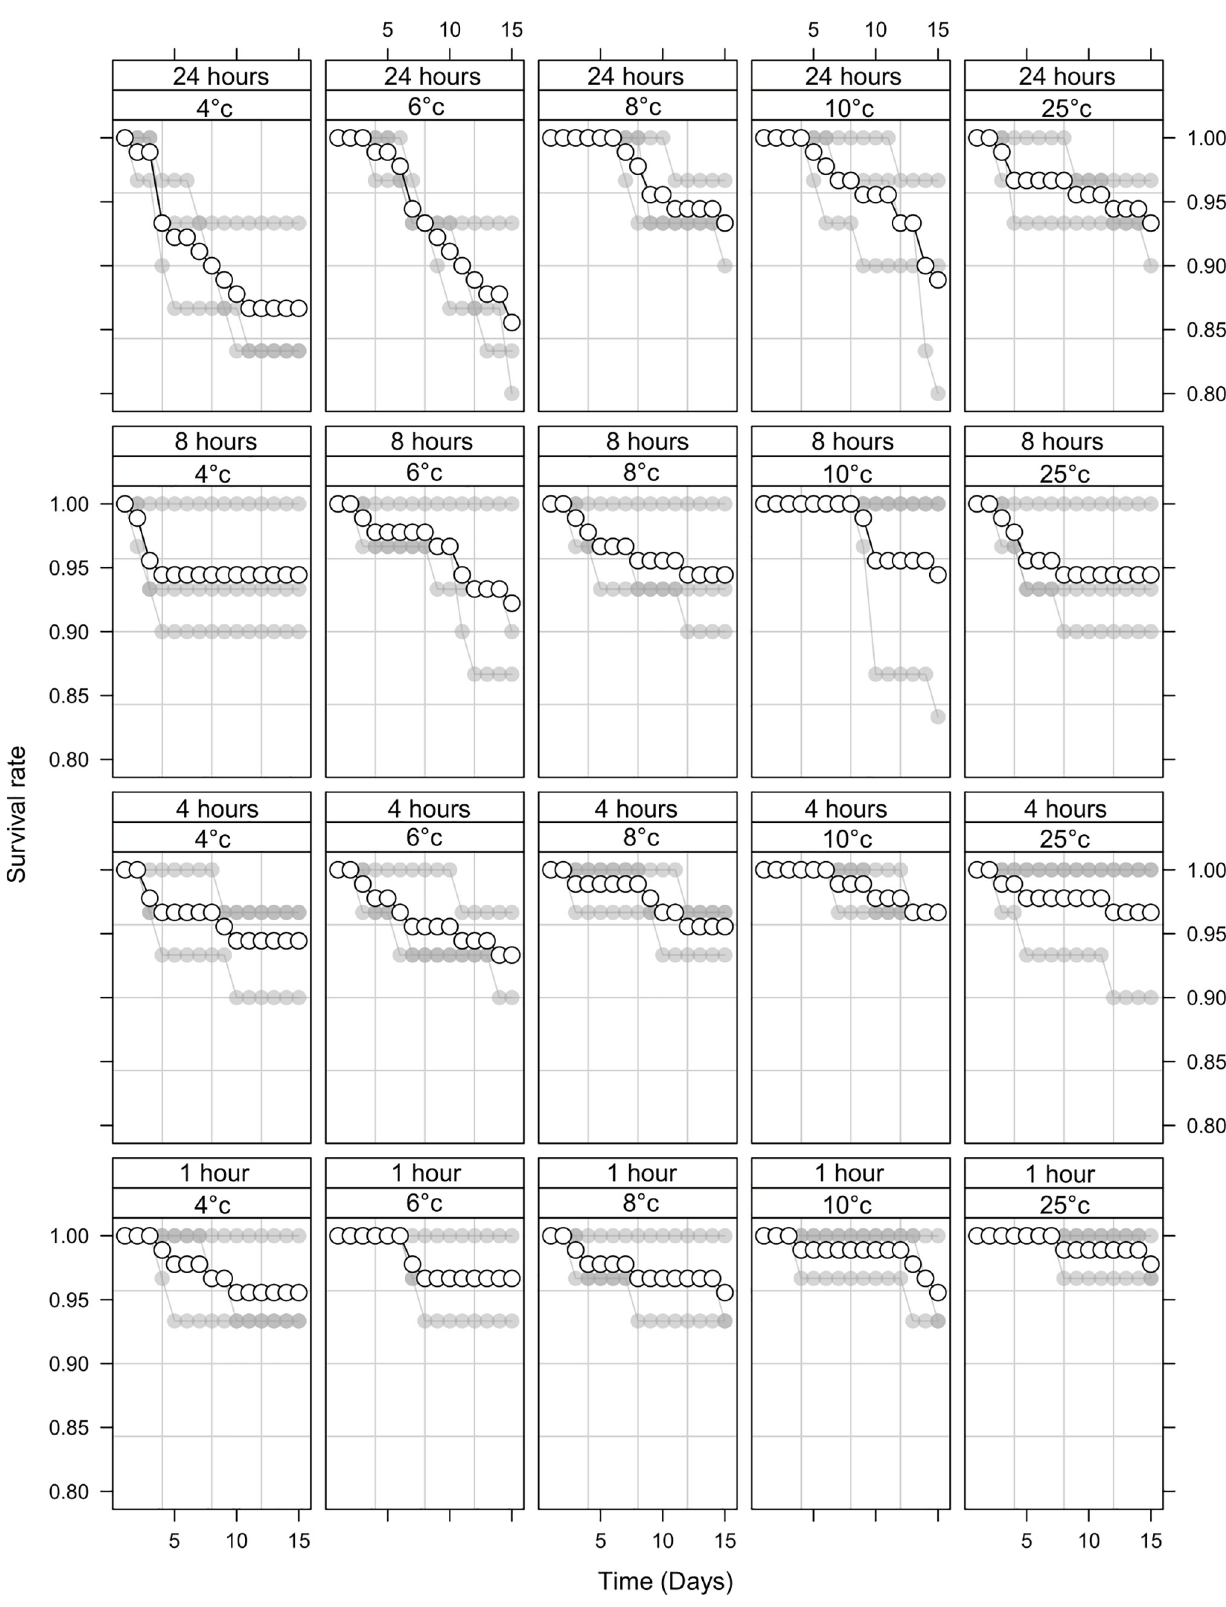
Fig 1. Mean ( ± standard error, SE) % survival of adult male Aedes aegypti 15 days following immobilisation at 4, 6, 8 and 10˚C for 1, 4, 8 or 24 h. Mean values are represented by white circles with a black outline. Each series of grey dots represents a repetition (one cage. of 30 adult males). https://doi.org/10.1371/journal.pone.0221822.g001 PLOS ONE | https://doi.org/10.1371/journal.pone.0221822 August 27,